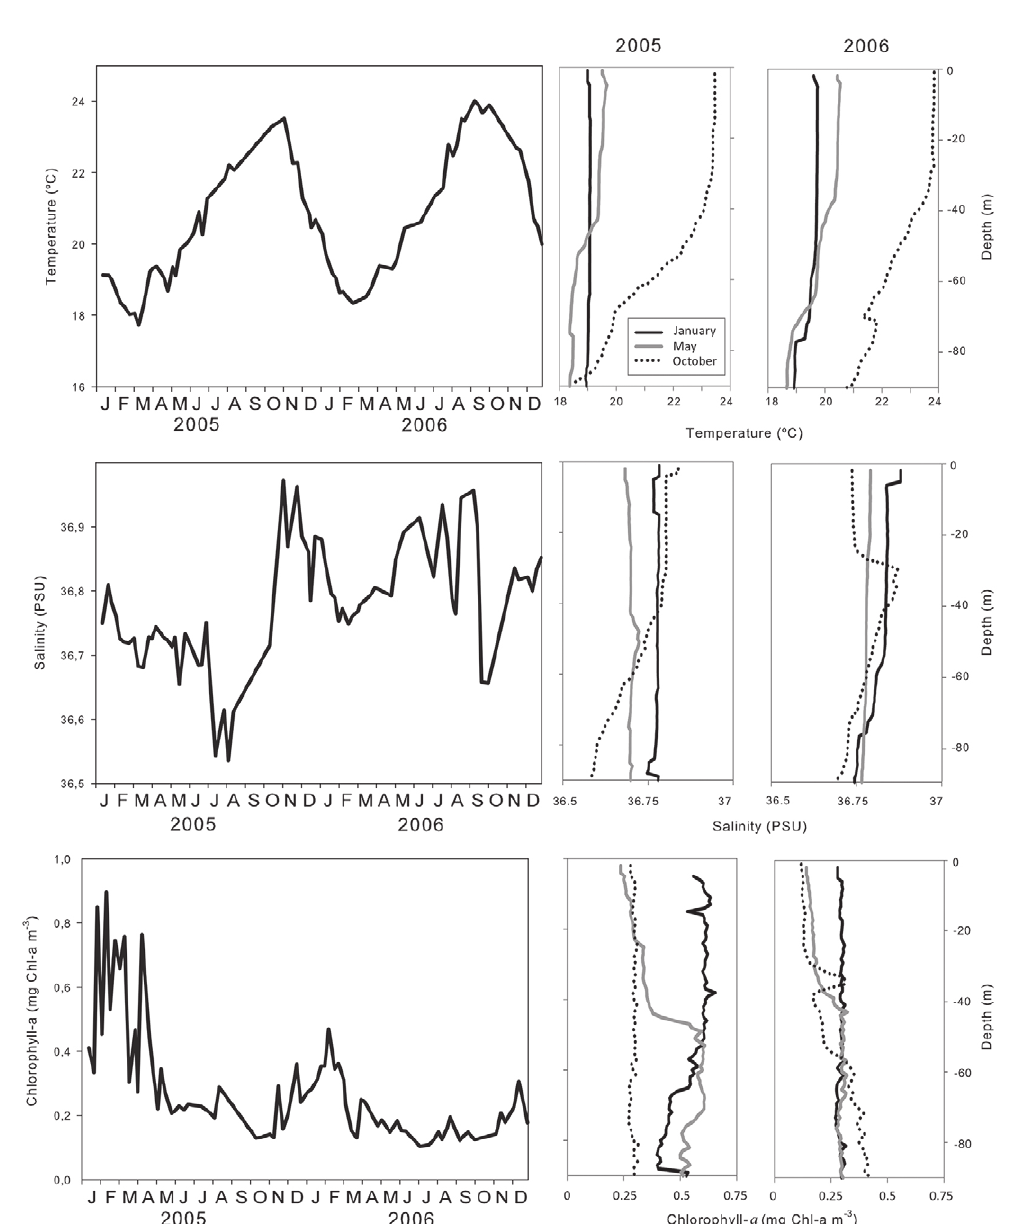
Fig. 2. – Temporal distribution of temperature (°C), salinity (practical salinity unit, PSU) at 2 m depth, and average chlorophyll a (15-75 m) (mg Chl- a m –3 ) from January 2005 to December 2006. Vertical profiles of temperature, salinity and chlorophyll a are averaged values for January, May and